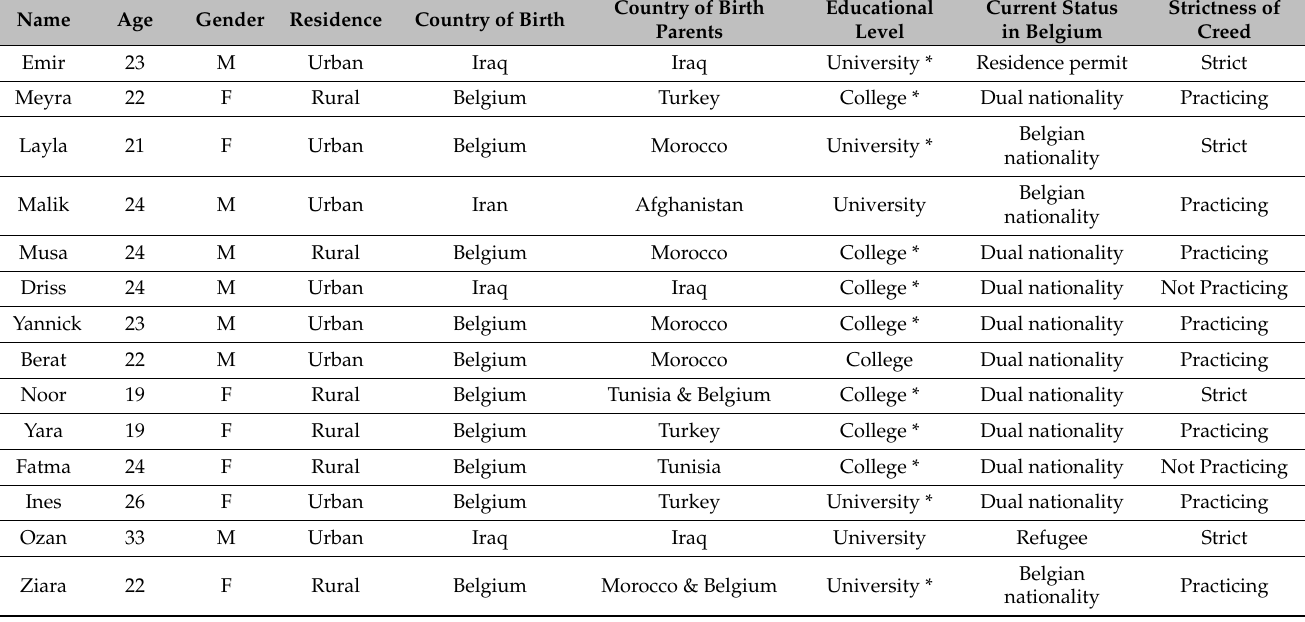
Table 1. Overview of our informants 2 .